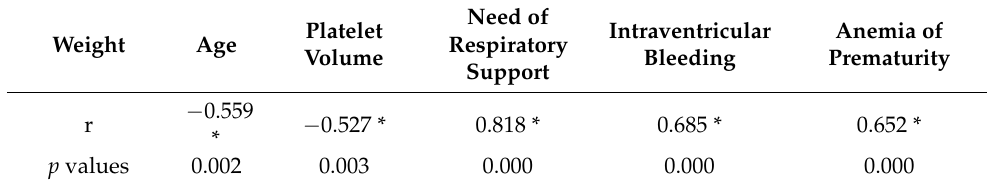
Table 7. Preterm newborn weight correlated with prematurity-related disorders and platelet volume in experimental